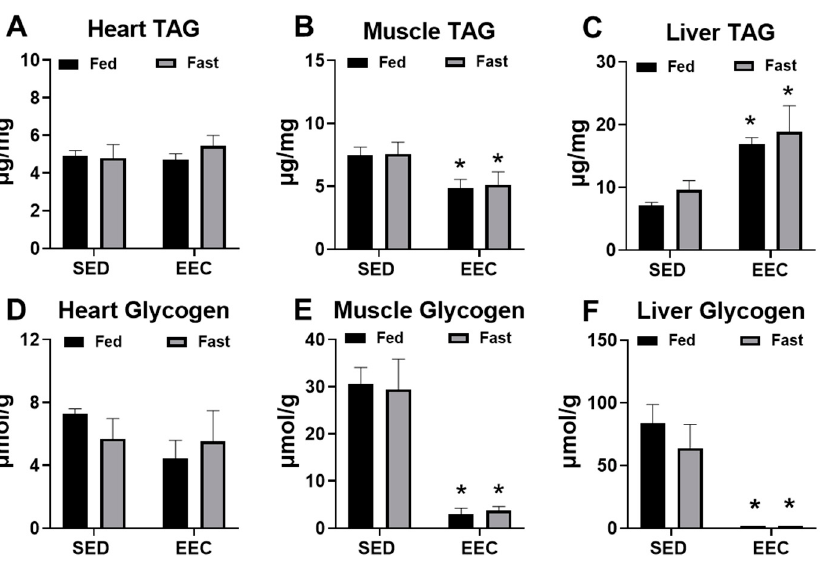
Figure 2. Fasting does not significantly alter triacylglycerol or glycogen stores in tissue. ( A ) Heart, ( B ) gastrocnemius, and ( C ) liver triacylglycerol (TAG) content in fed and fasted female mice. Tissues were harvested immediately following an endurance exercise capacity (EEC) test ( n = 3–4 each group). ( D ) Heart, ( E ) gastrocnemius, and ( F ) liver glycogen content in fed and fasted female tissues harvested immediately following the EEC ( n = 3–4 each group). A cohort of sedentary, non-exercised (SED) fasted and fed mice were used for comparison ( n = 4–6 each group). * p < 0.05 vs. SED.